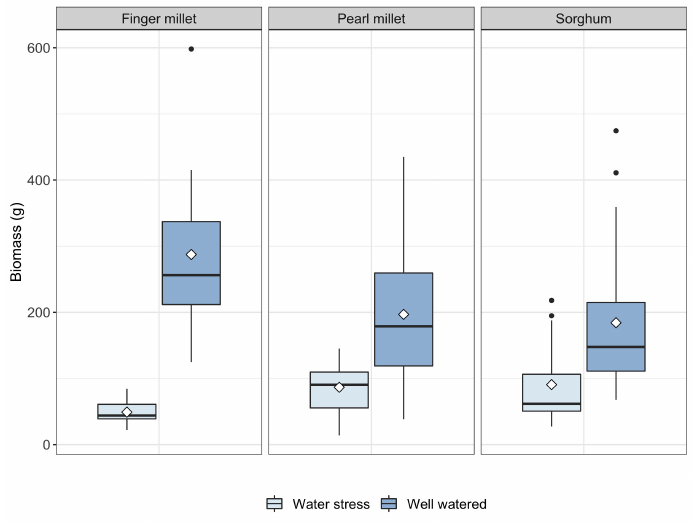
Figure 1. Boxplot of biomass production of finger millet, pearl millet and sorghum species. Biomass represents the sum of the weights of all the plant components: stem, leaves, panicles and tillers. Horizontal bar = median, white diamond = mean, black dots =